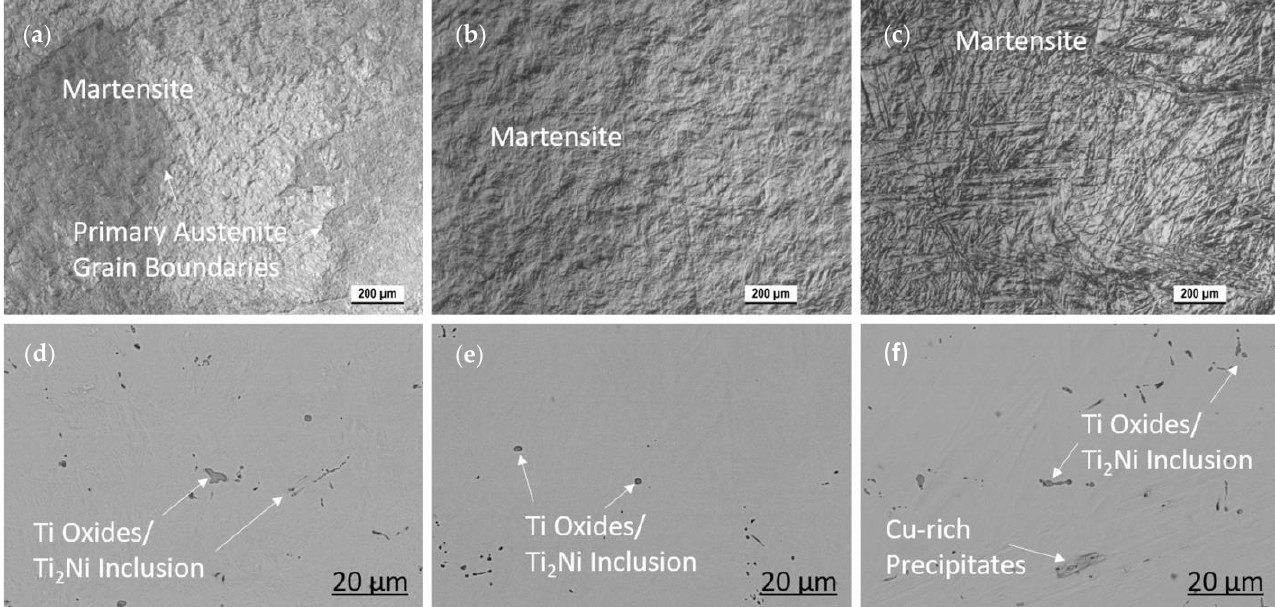
Figure 7. The microstructure of homogenized (900 °C × 24 h, Furnace cooled) group B VIM alloys: Optical and SEM micrographs of the ( a , d ) 5-Pd; ( b , e ) 15-Pd; and ( c , f ) 20-Pd alloys, respectively.